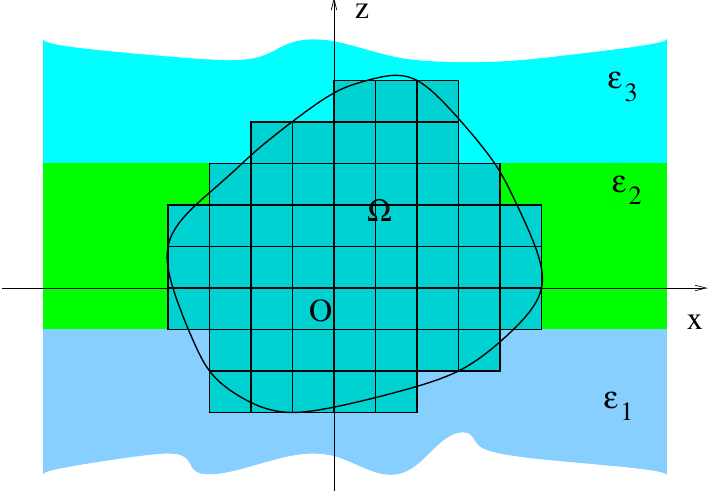
Figure 4. Object with a support Ω inside a multilayer system. When the object contains a interface, it must pass between the discretization elements because Green’s function cannot be calculated for a dipole or an observation on the